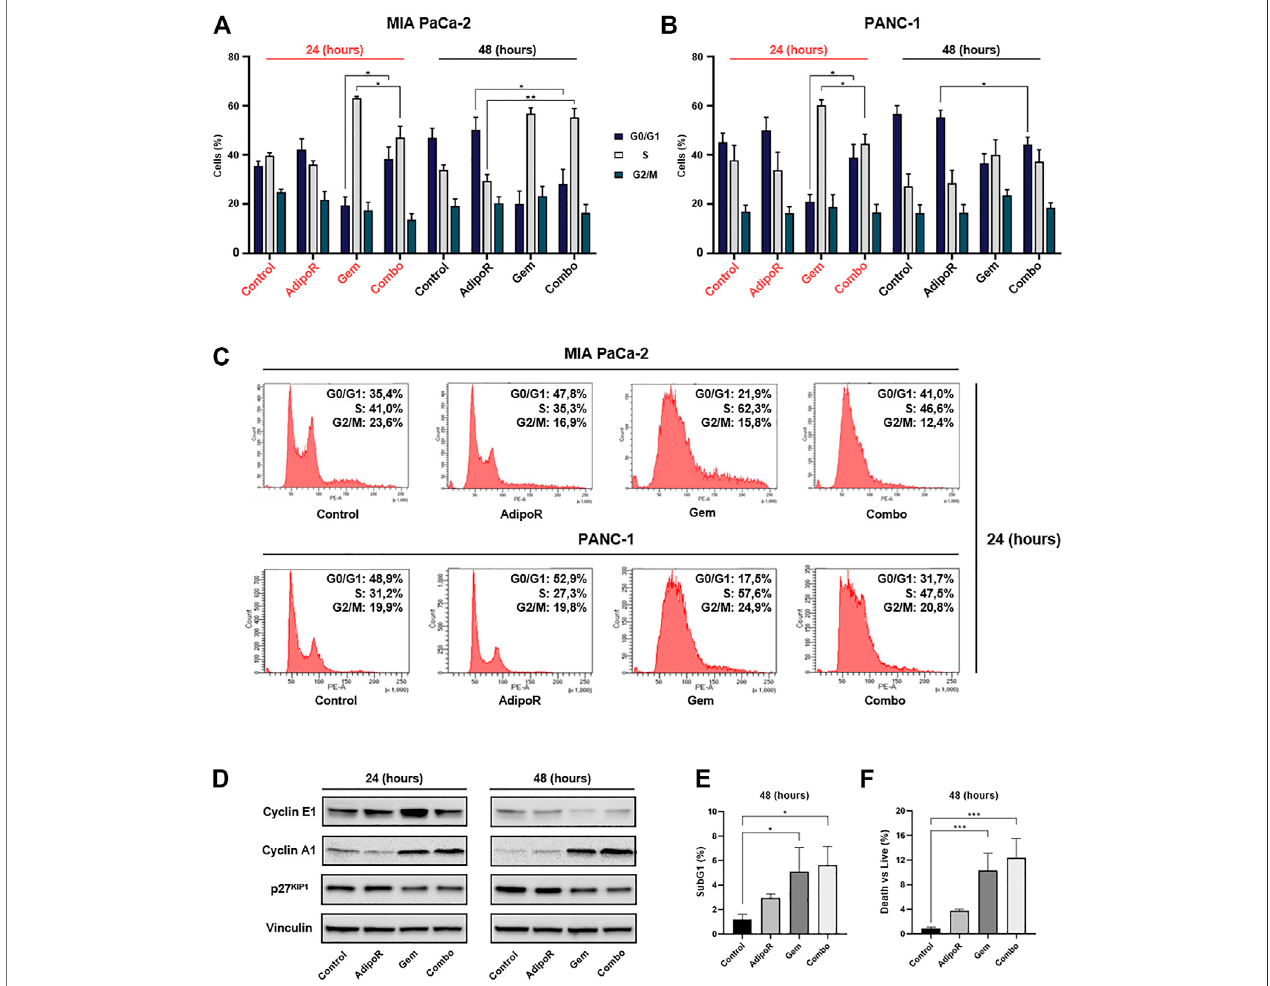
FIGURE4 | Investigation ofsingle and combinatory consequences on cell cycle distributionin PDAC cells. MIA PaCa-2 wasexposed and not (control) to10 µg/ml AdipoR, 15 nM Gem, and AdipoR plus Gem over a period of 24 and 48 h (A) . PANC-1 cells, instead, were treated and not (control) with 10 µg/ml AdipoR, 50 nM Gem, and combination for the same temporal extension (B) . Subsequently, the relative cell phase distribution was de fi ned by FACSCelesta TM using PI as DNA staining. MIA PaCa-2 and PANC-1 representative histogram plots at 24 h (C) . (D) Cyclin A1, cyclin E1, and p27 KIP1 expression levels were obtained in reaction to 10 µg/ml AdipoR, 15 nM Gem, and combination in MIA PaCa-2. (E) Relative subG1 amount. (F) Trypan blue discrimination analysis. Either (E) or (F) show MIA PaCa-2 results cultured in media containing AdipoR, Gem, and AdipoR plus Gem under the same (B) experimental conditions. Displayed data are expressed in percentage as average value ± SD of three independent experiments. * p < 0.05, ** p < 0.01, *** p < 0.001 by Tukey ’ s multiple comparisons